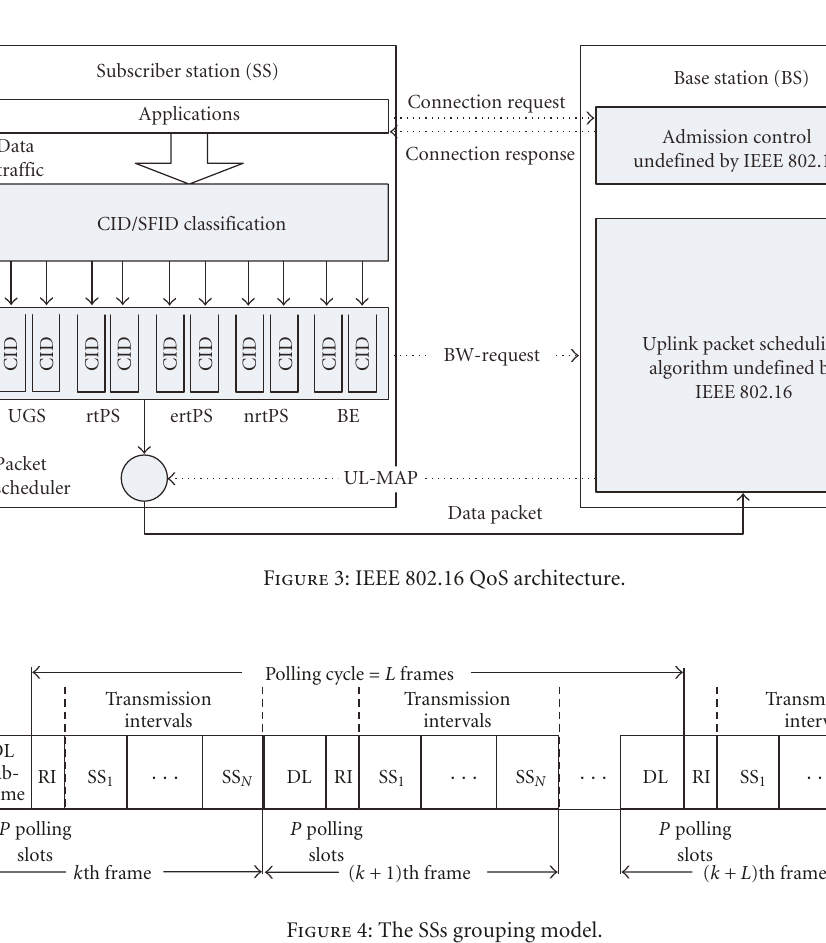
Figure 4: The SSs grouping